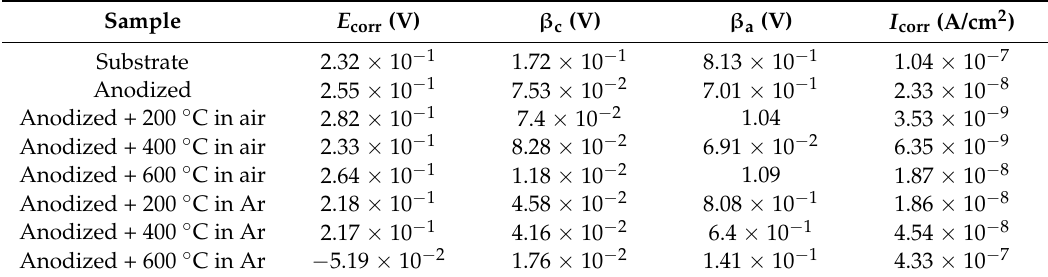
Table 5. Electrochemical parameters of the potentiodynamic polarization curve.